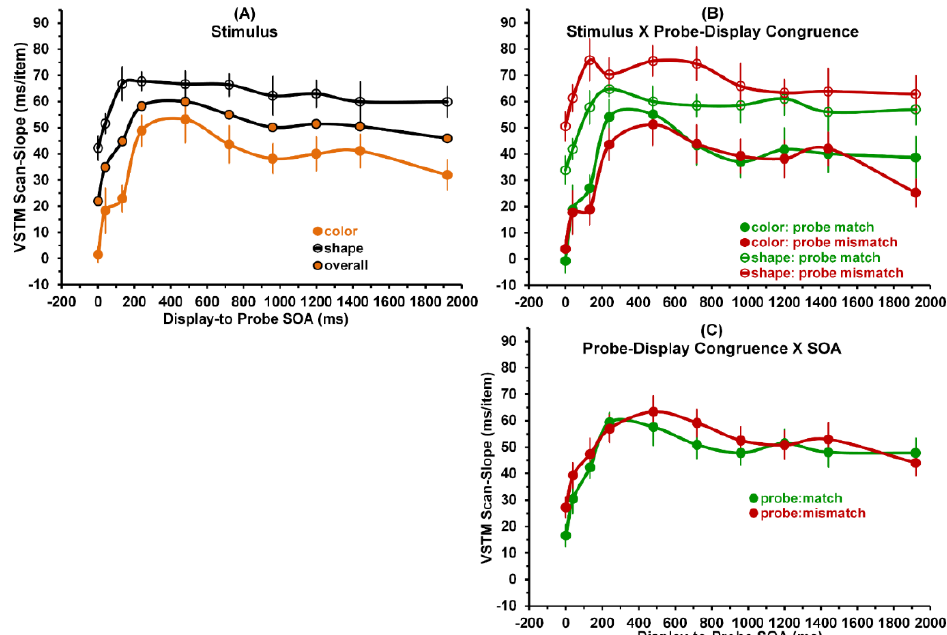
Figure 5. VSTM scan – slopes as a function of display – to – probe SOA. (Panel A ): Averaged across probe – display congruences, orange, open, and orange – filled circles denote respectively color, shape, and overall results. The data show the significant main effects of stimulus and SOA. (Panel B ): Red and green circles denote respectively probe mismatch and match conditions. Open and filled circles denote respectively shape and color stimuli. The data show the significant interaction between stimulus and probe–display congruence across SOAs. (Panel C ): Insignificant interaction between probe–display congruence and SOA.